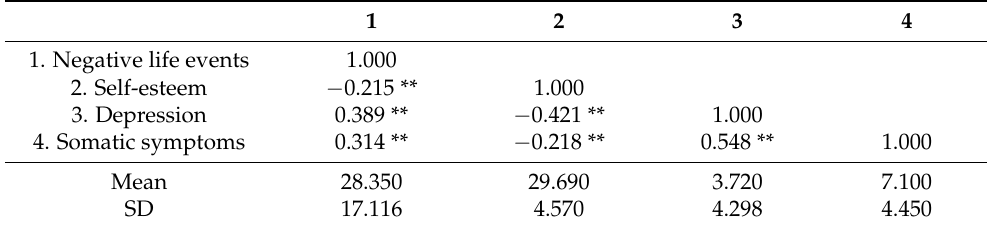
Table 4. Correlations between negative life events, self-esteem, depression, and somatic symptoms.